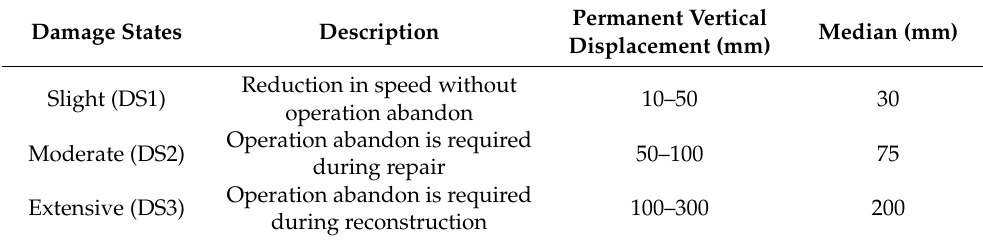
Table 1. Railway embankment damage states